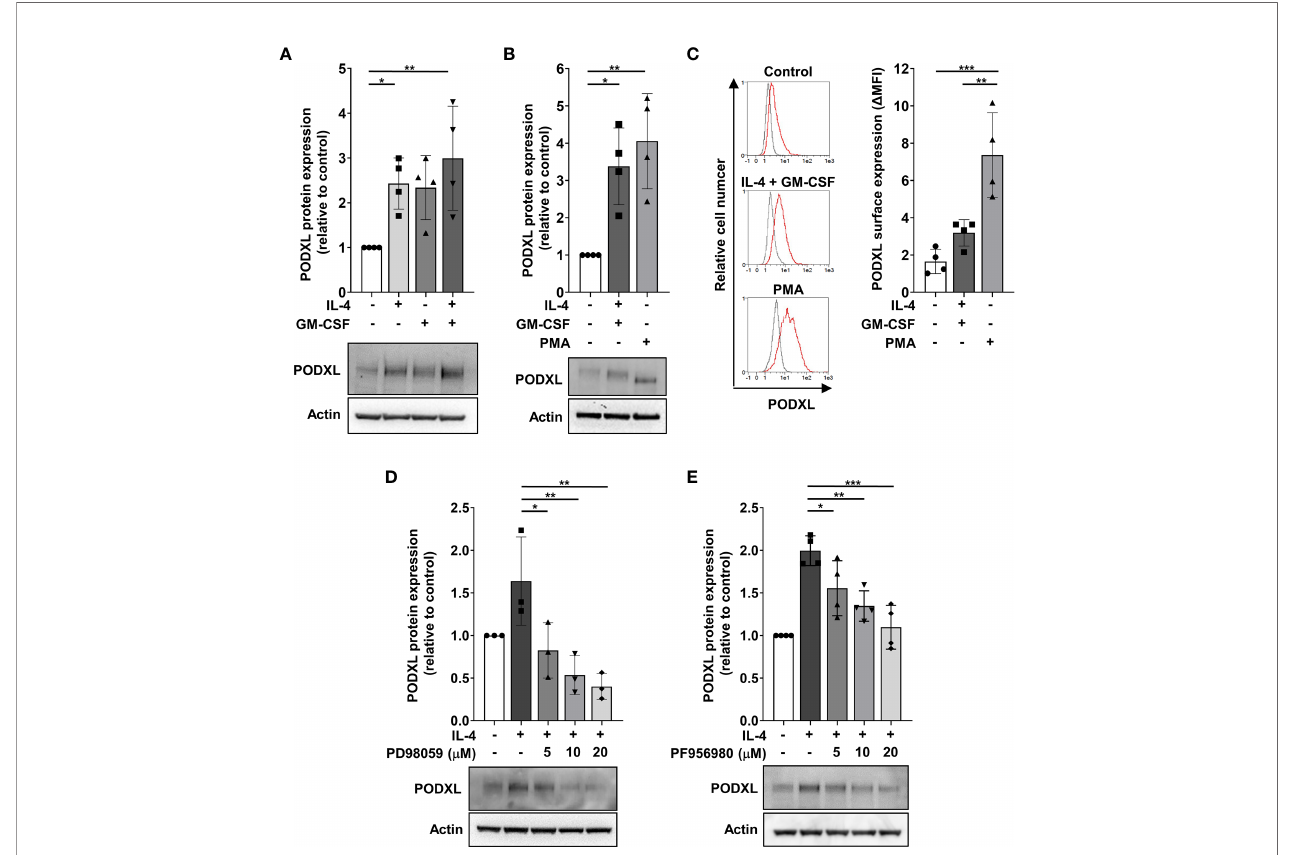
FIGURE 3 | PODXL expression is positively regulated by IL-4 through MEK/ERK and JAK3/STAT6 signaling pathways in myeloid cells. THP-1 cells were stimulated with IL-4 (400 U/ml) and GM-CSF (800 U/ml) cytokines (A) for 96 h or with PMA (100 ng/ml) (B) for 48 h followed by a resting period of 48 (h) Afterwards, total cell lysates were subjected to Western blotting using a speci fi c monoclonal antibody against PODXL. Actin was used as loading control. Bar graphs represent the mean ± SD of PODXL levels relative to those of unstimulated cells of four independent experiments. *p < 0.05, **p < 0.01, one-way ANOVA. (C) PODXL surface expression was analyzed by fl ow cytometry using a biotinylated goat anti-human PODXL antibody followed by PE-conjugated streptavidin. Overlay histograms show surface expression of PODXL (red line) and isotype control (grey line) from one representative donor. Graph shows PODXL surface expression ( D MFI= PODXL MFI - isotype control MFI) of four independent experiments. **p < 0.01, ***p < 0.001, one-way ANOVA. (D, E) Effect of signaling pathway inhibitors on IL-4-induced PODXL expression in THP-1 cells. Cells were incubated with 400 U/ml IL-4 in the presence of increasing concentration of MEK/ERK signaling pathway inhibitor (PD98059) (D) or JAK3 signaling pathway inhibitor (PF956980) (E) for 96 (h) Then, cell lysates were subjected to Western blot analysis with a monoclonal anti-PODXL antibody. Actin was used as loading control. Bar graphs represent the mean ± SD of PODXL levels relative to those of unstimulated and untreated cells of three (D) or four (E) independent experiments. A representative blot is shown below each graph. *p < 0.05, **p < 0.01, ***p < 0.001, one-way